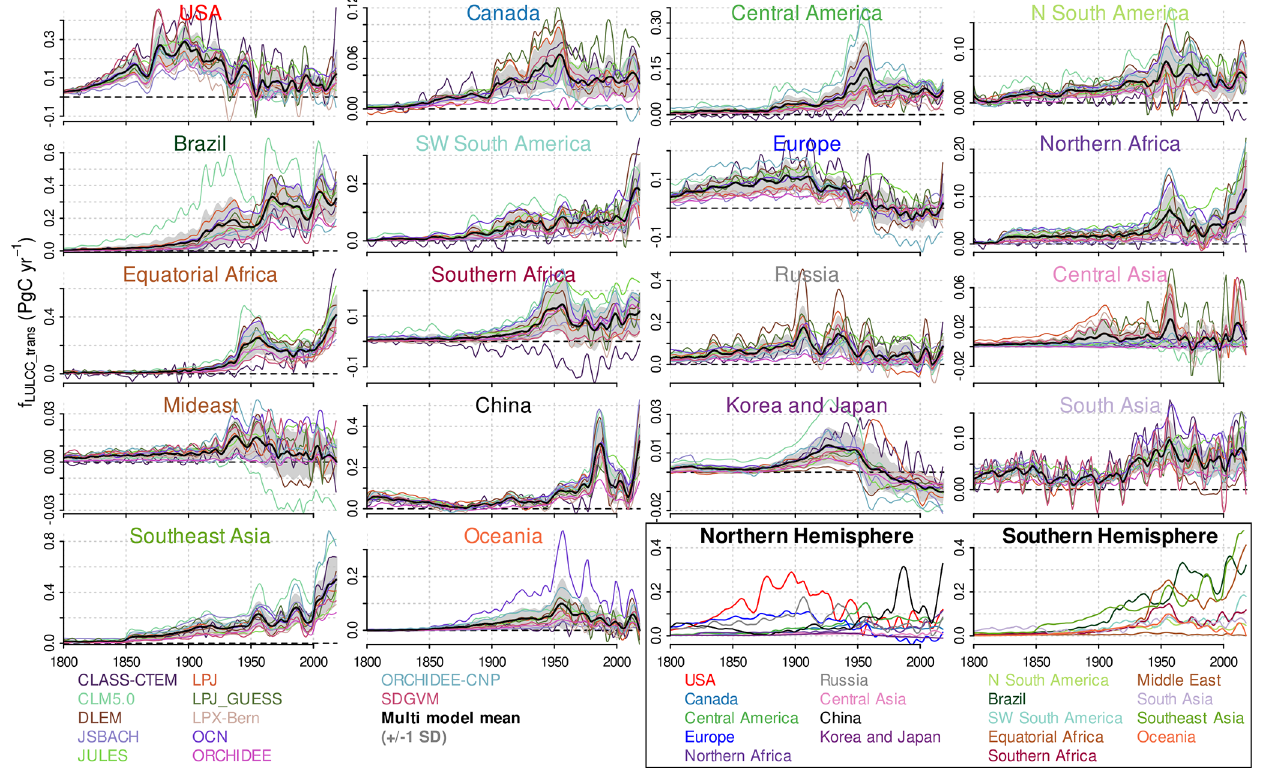
Figure A7. Region-wise smoothed annual f LULCC_trans for different models from 1800 onward (compare Eq. 1). For a discussion of individual models refer to Sect. A1. The last two panels show regional ensemble means on a uniform